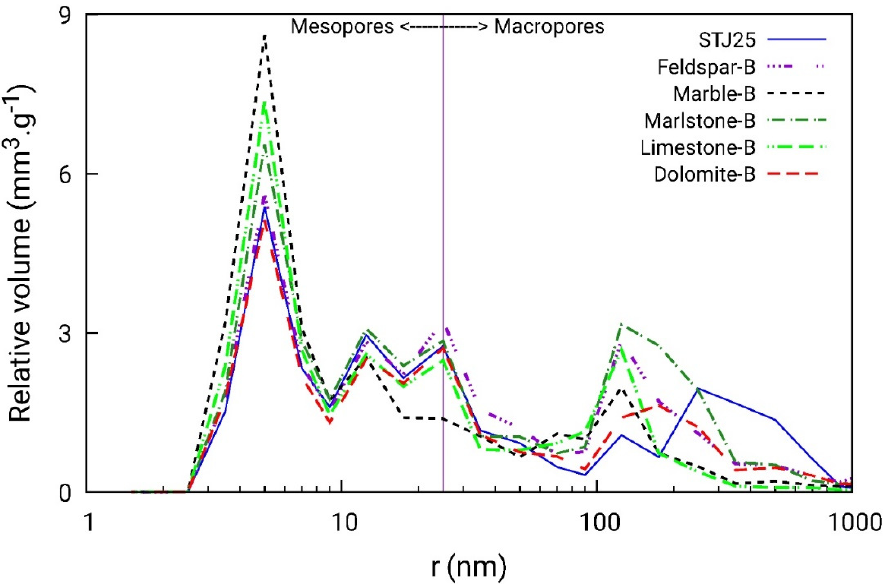
Figure 2. The pore-size distribution of samples with WSP and the clear basic mass obtained by mercury porosimetry.